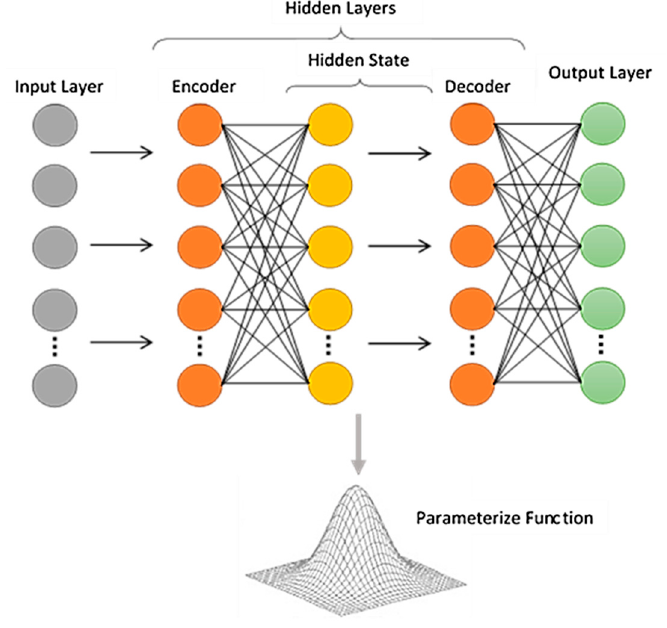
Figure 1. Auto-encoder Deep Neural Networks Figure 1. Auto ‐ encoder Deep Neural Networks Construction.